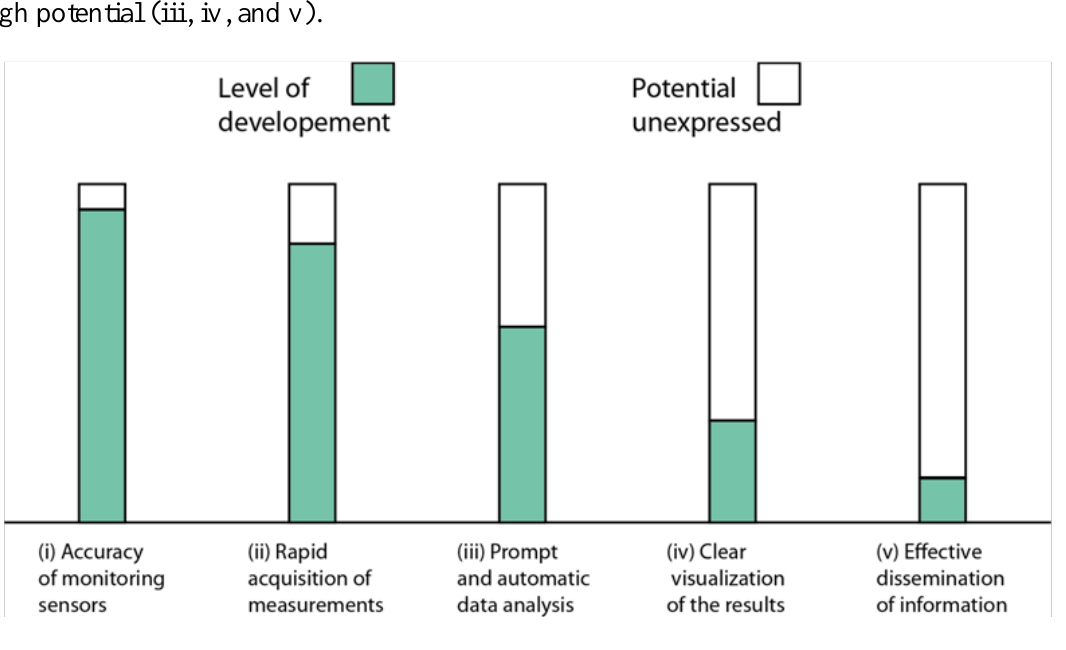
Figure 1. Bar-chart to schematically represent the main requirements of EWS in landslide scenarios. Green areas represent the current level of development achieved, white areas stay for unexpressed potential, respectively. In the context of EWS, the state-of-art of some elements already reached a high level of development (i and ii), while others have still a high potential (iii, iv, and